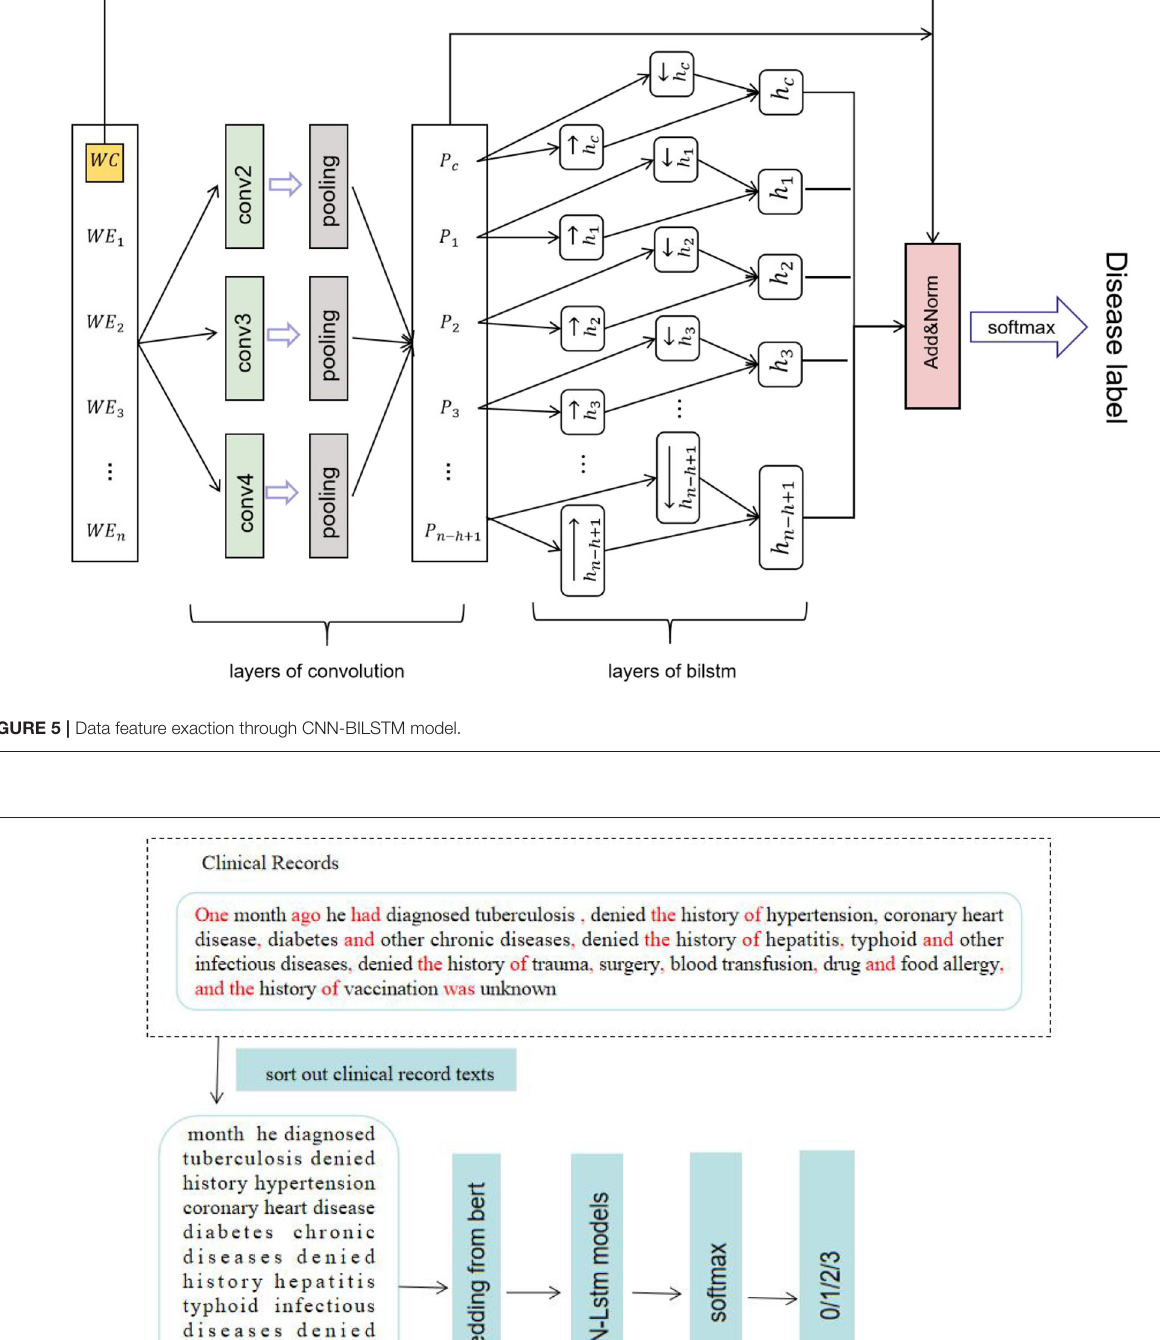
Frontiers in Public Health |